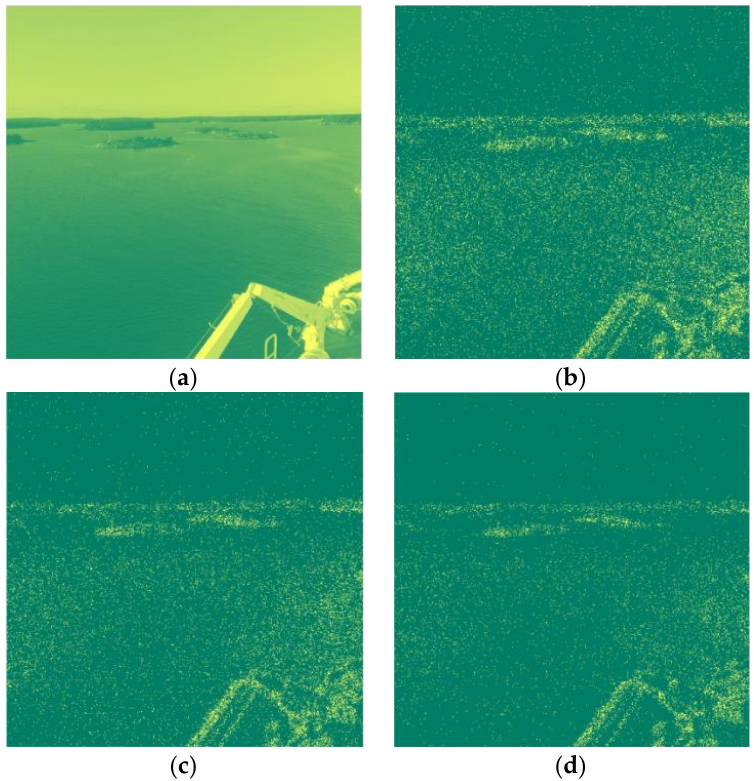
Figure 1. Natural cover image and difference arrays of the cover and stego-image. ( a ) Cover image. ( b ) DI of the cover and HILL stego-image. ( c ) DI of the S-UNIWARD stego-image. ( d ) DI of the WOW stego-image.